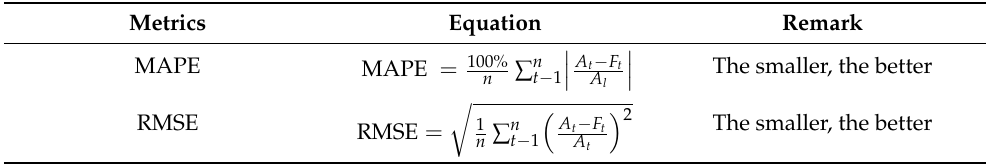
Table 3. Metrics for evaluating the accuracy of forecasting